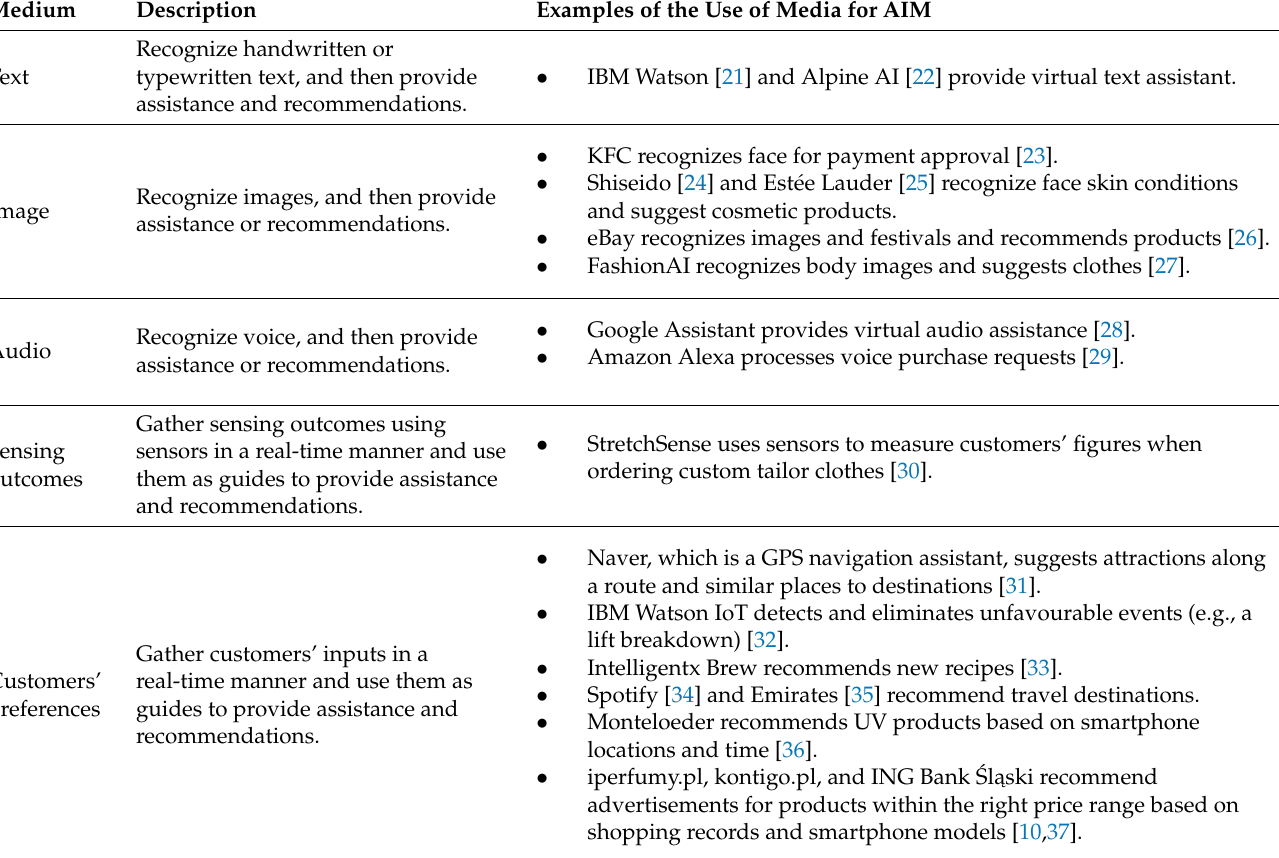
Table 2. Media used by